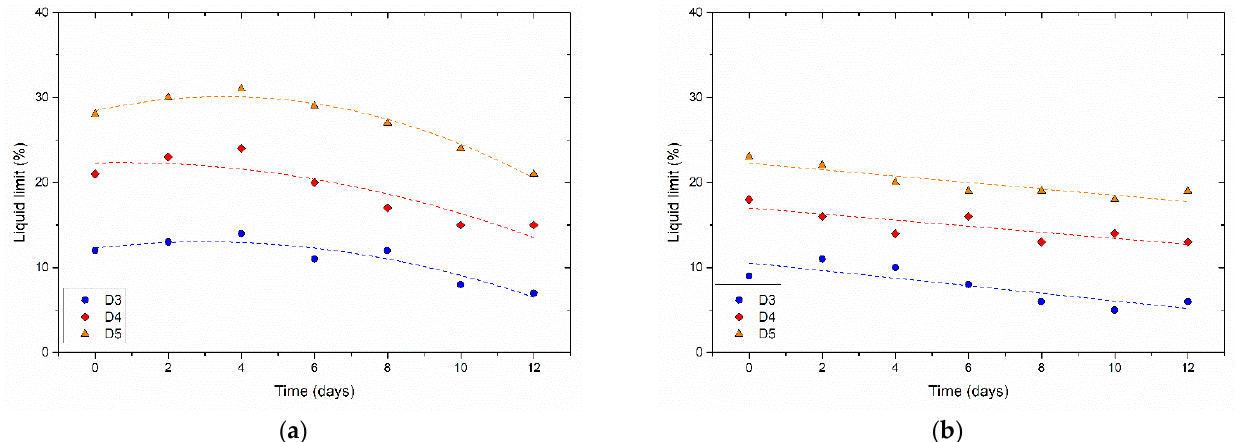
Figure 6. Change of liquid limit of samples treated with the diffusion method: ( a ) deionized water; ( b ) 2M-NaCl brine.